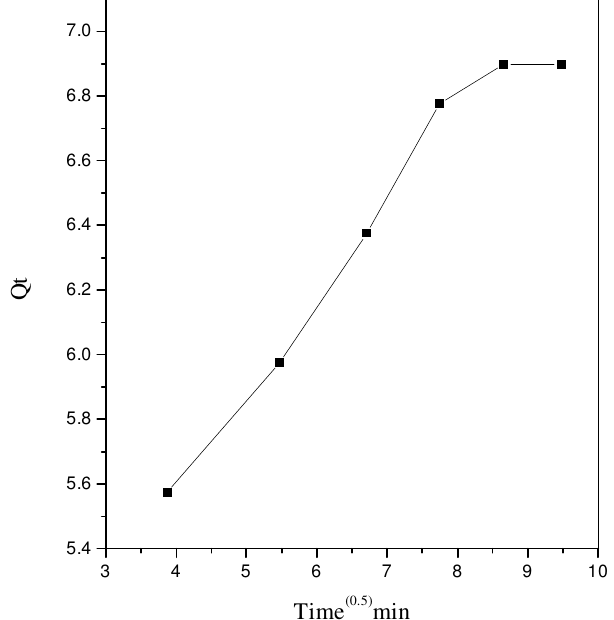
Figure 5 . Intraparticle diffusion effect for the adsorption of RDB by PSC. [RDB] = 10mg / L; Adsorbent dose = 50mg / 50mL; Contact time =